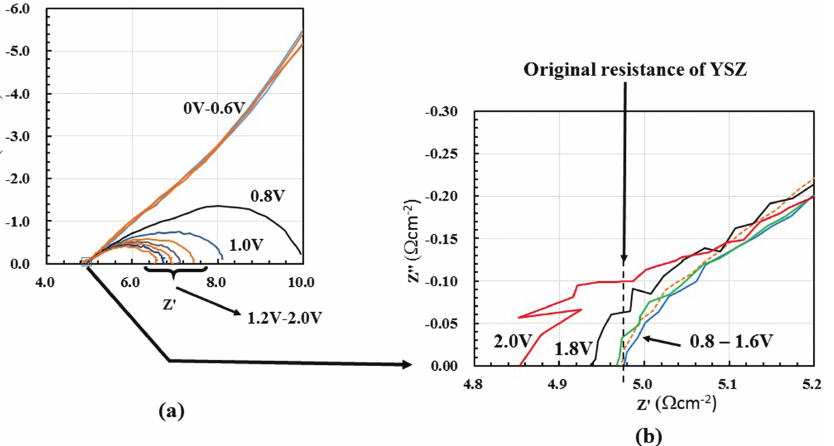
Figure 3: (a) Variation of Nyquist diagram with voltage ranging from 0 V (OCV) to 2.0 V at 800°C and (b) a larger-scale view of the points of intersection from